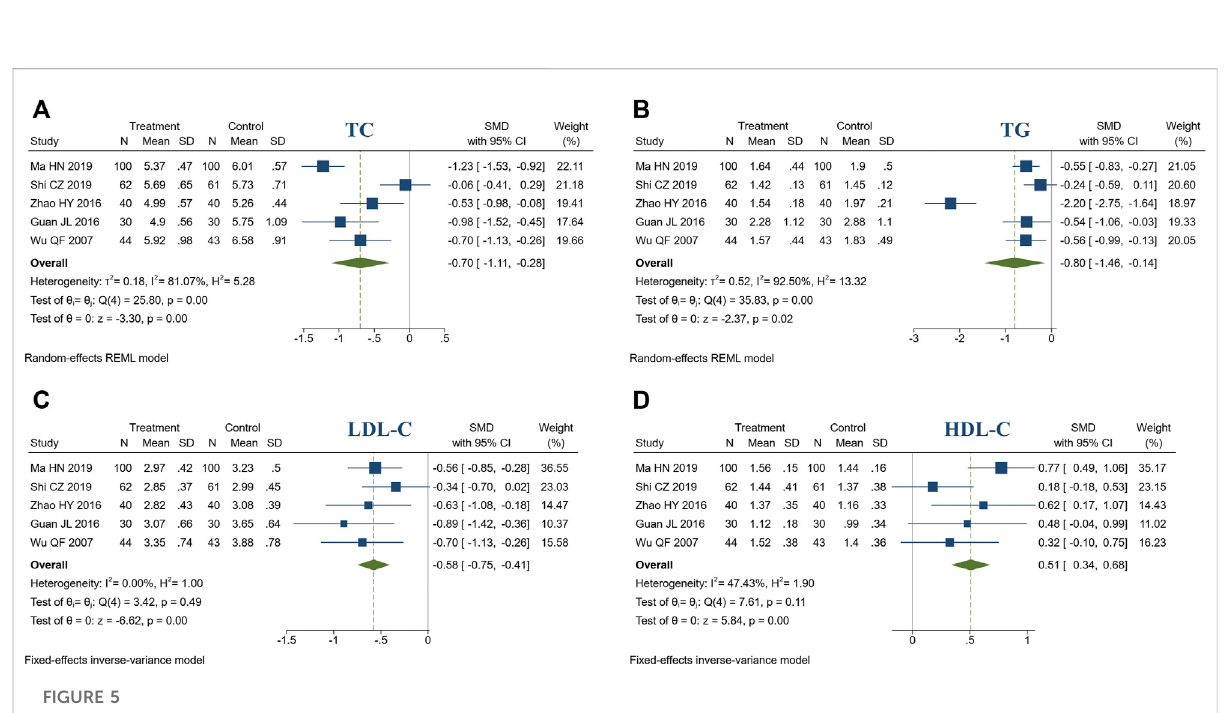
FIGURE 5 Forest plot of blood lipids. (A) TC; (B) TG; (C) LDL-C; (D)